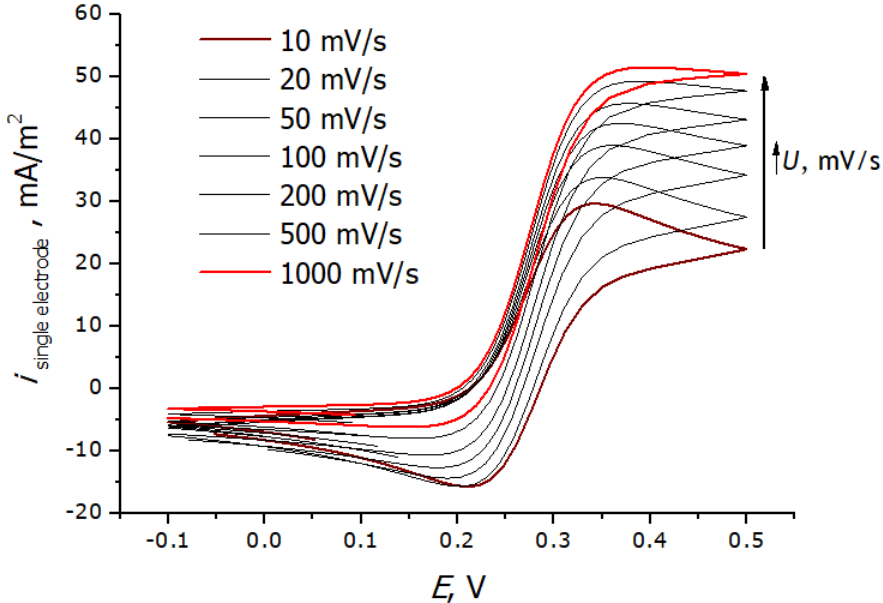
Figure 12. CV of an ensemble with an interelectrode distance of 20 µ m at various sweep rates.